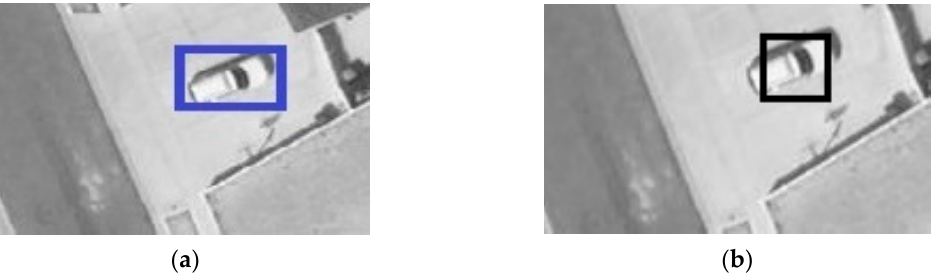
Figure 4. Two annotation methods: ( a ) sample of annotation 1. ( b ) sample of annotation 2.